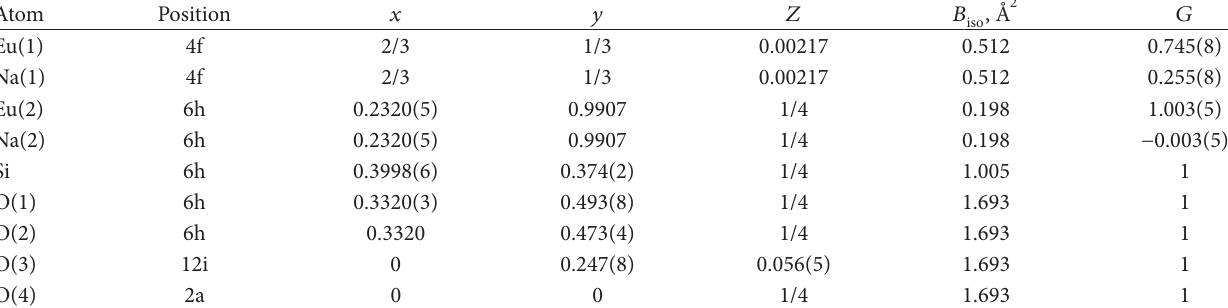
T 2: Coordinates, isotropic thermal parameters of atoms